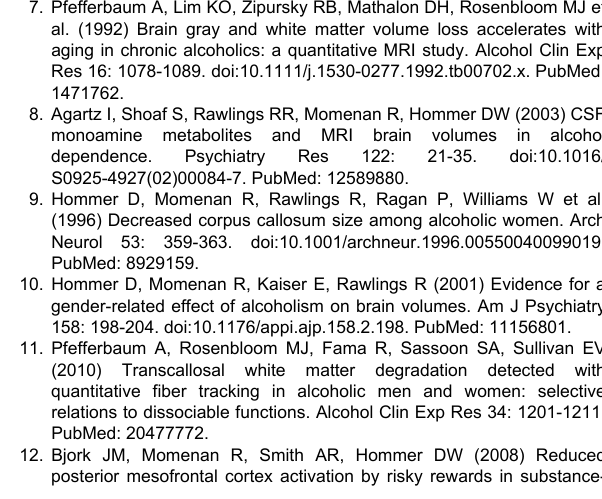
Table S1. Current Axis I Diagnoses for alcohol dependent subjects without PTSD (ALC) and alcohol dependent subjects with PTSD